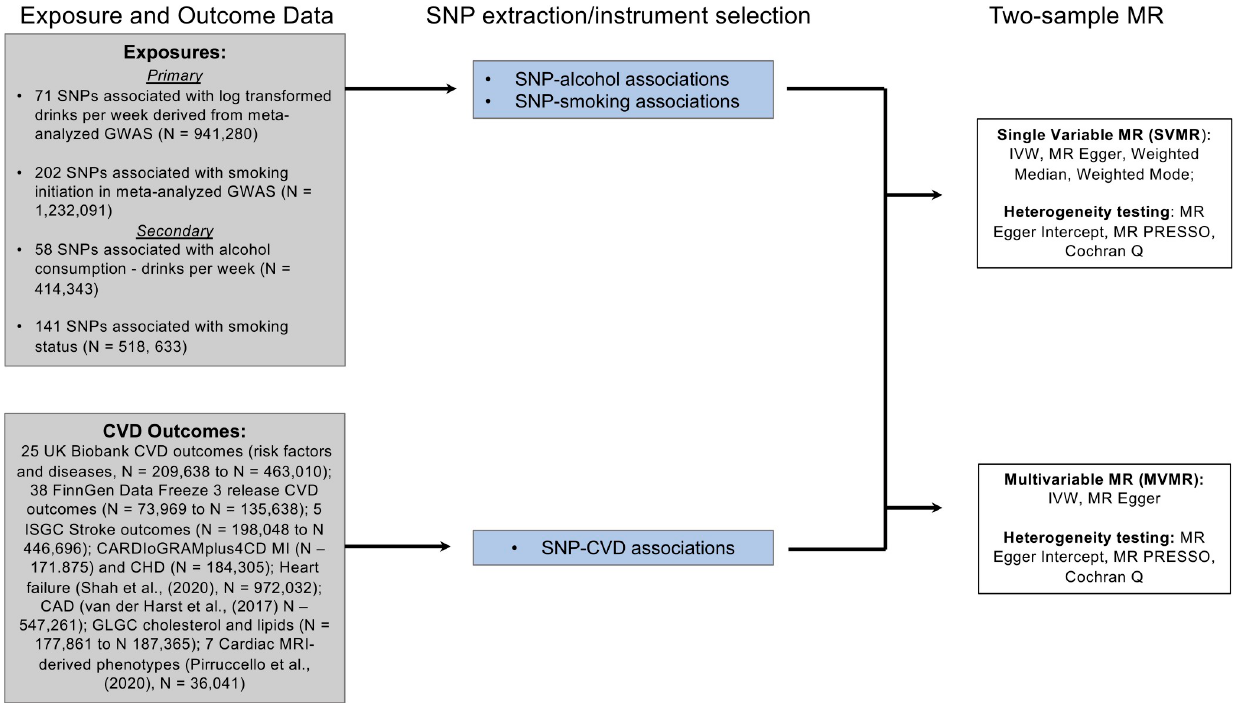
Fig 1. Study overview. CAD, coronary artery disease; CARDIoGRAMplusC4D, Coronary ARtery DIsease Genome-wide Replication and Meta-analysis (CARDIoGRAM) plus The Coronary Artery Disease (C4D) Genetics; CHD, coronary heart disease; CVD, cardiovascular disease; Dx., diagnosis; GLGC, Global Lipids Genetics Consortium; GWAS, genome-wide association study; IVW, inverse variance weighted; MR, Mendelian randomization; MVMR, multivariable Mendelian randomization; SNP, single nucleotide polymorphism; SVMR, single-variable Mendelian randomization.